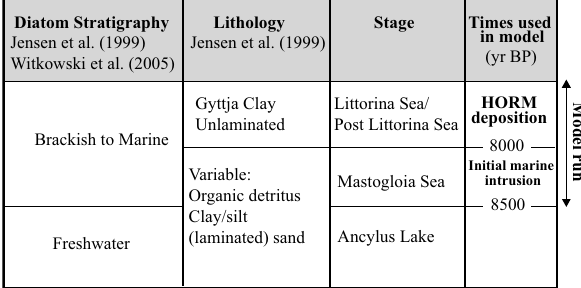
Fig. 2. Simplified stratigraphy for the Ancylus Lake – Mastogloia Sea – Littorina Sea transition and the times employed in the